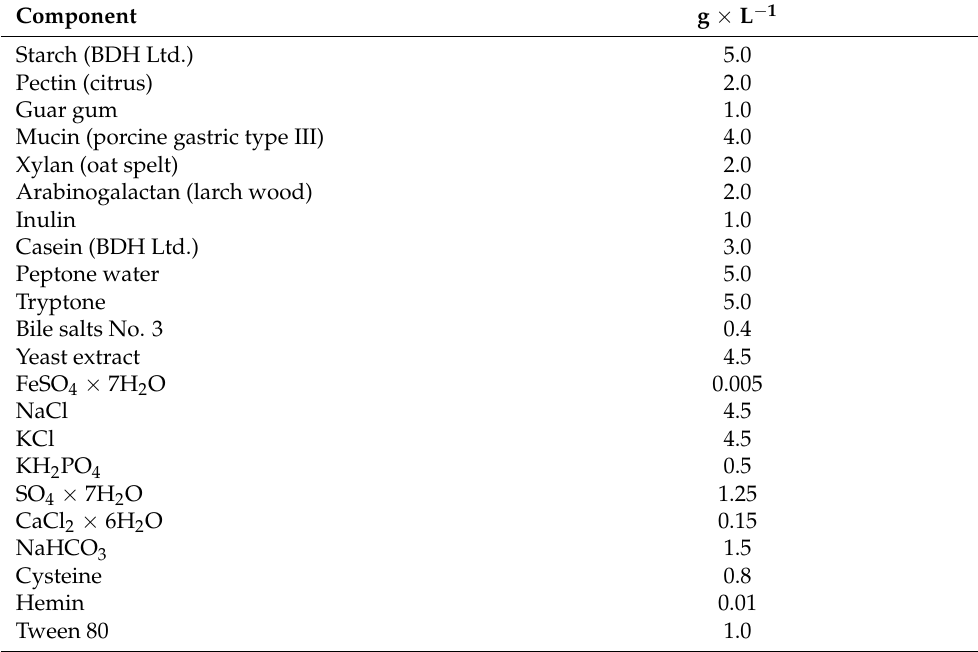
Table 2. Continuous culture growth medium (CMGM, g liter − 1 in distilled water)